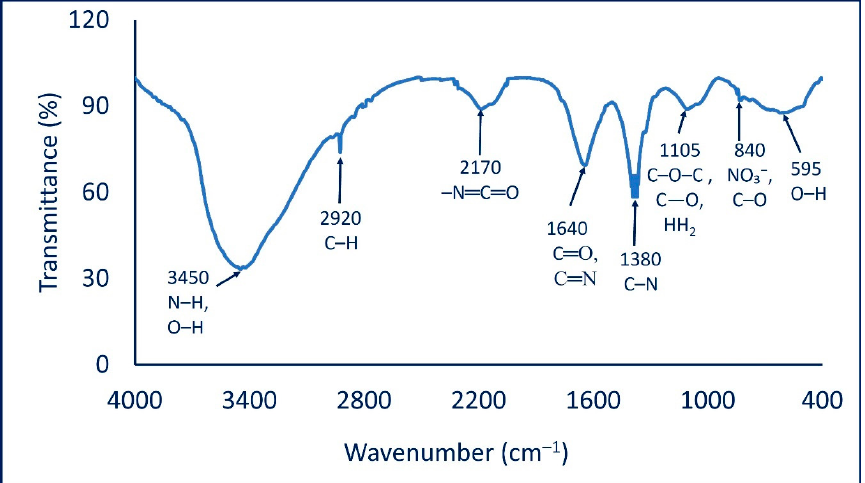
Figure 2. FT-IR chart of Ag-NPs fabricated by cell-free filtrate of A.